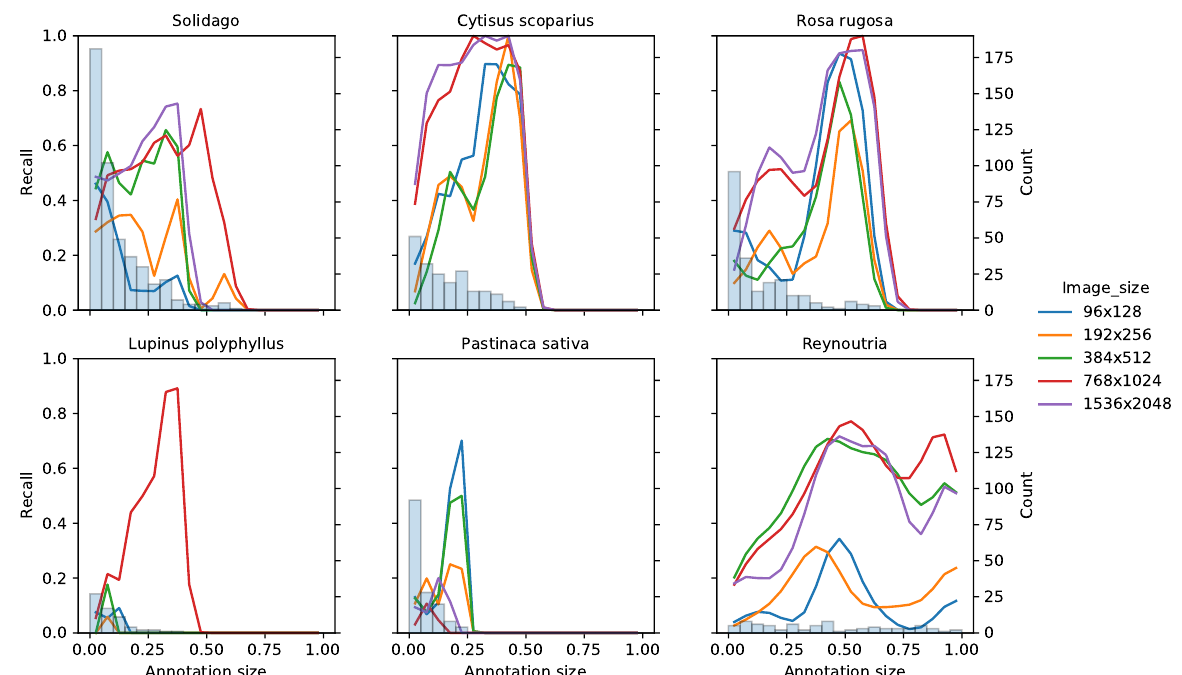
Figure 8. Recall of the ResNet50V2 models on the validation set as a function of the annotation size relative to image size. The validation images were binned according to the relative size of their respective annotations with respect to the image size (“annotation size”). Each line shows the recall (left axis) of a ResNet50V2 model with a given input image size across the binned annotation sizes. The recall lines were “smoothed”, using kernel density estimation. The number of images in each bin is shown as vertical bars (right axis).